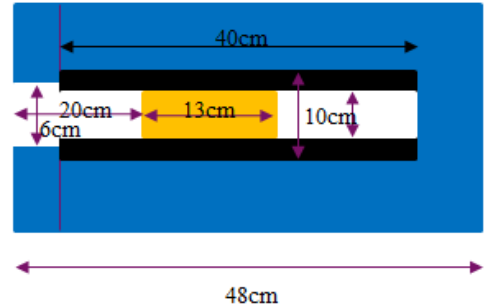
Fig. 3. Polyethylene (blue) moderator (left). 3 He detector system design (right).